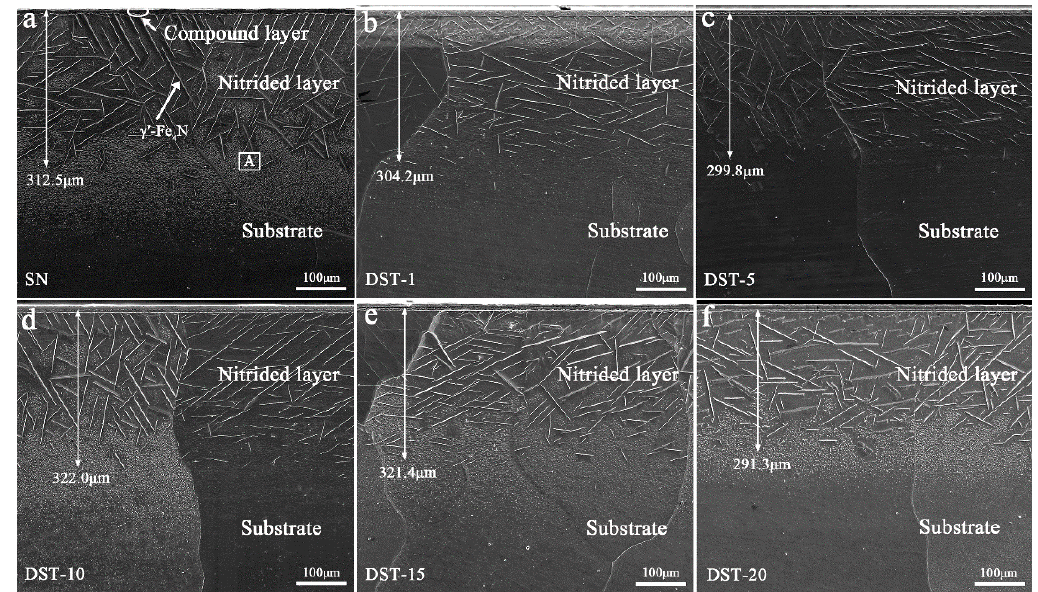
Figure 2. The samples with 5.76 × 10 − 3 mg/mm 2 Ni coating ( a , b ) and with 34.70 × 10 − 3 mg/mm 2 Ni coating ( c , d ).